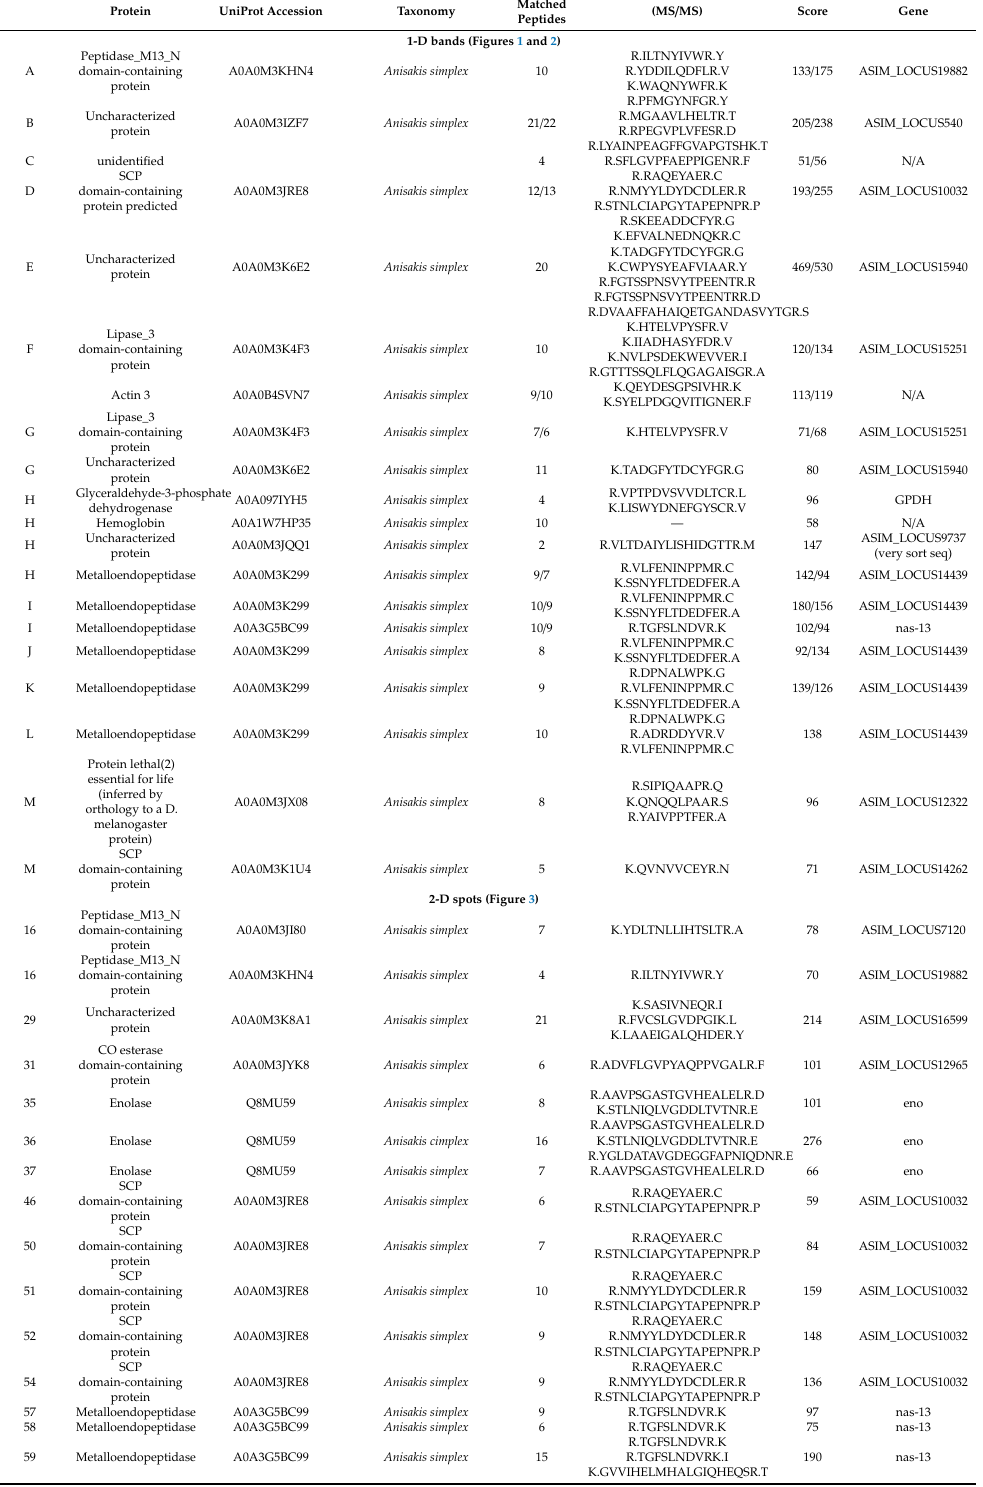
Table 1. Identified immunoreactive protein markers using MASCOT database searches. For 1-D experiments the results are for the two replicates (GC 1 , GC 2 ) except for bands L and M which were negative for GC 2